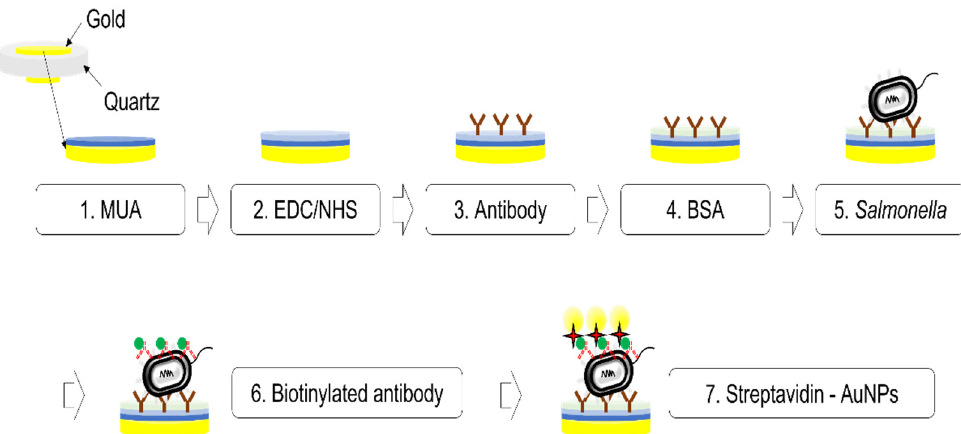
Figure 3. A procedure for antibody immobilization, Salmonella detection, and signal amplification. Each step was processed continuously and the PBS washing step was included between each step to remove unbounded residue.